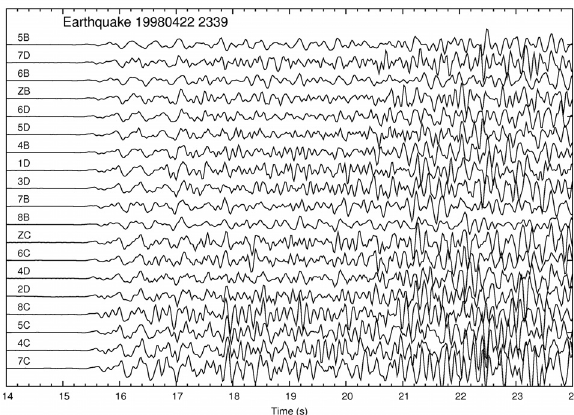
Figure 2. Seismograms of the earthquake 19980422 2339 recorded at the array stations. The similarity of the waveform among the sta- tions is evident only at the beginning and at lower frequency. Few seconds after the onset many seismograms look quite different each other, both in shape and